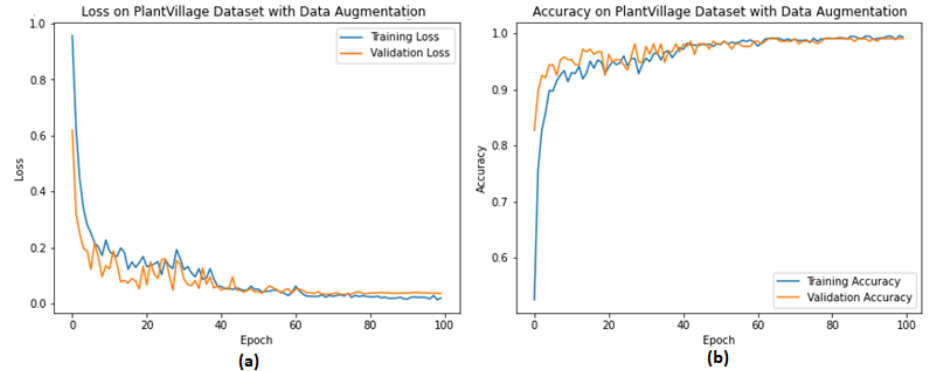
Figure 13. ( a ) Accuracy graph of PDDCNN on PlantVillage using data augmentation. ( b ) Loss graph of PDDCNN on PlantVillage using data augmentation.